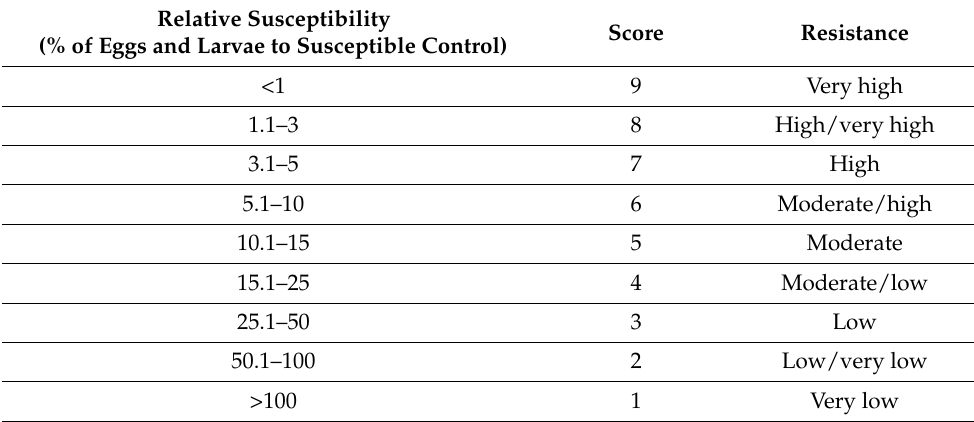
Table 1. EPPO scale for accounting the infestation rate of potato cultivars by G. rostochiensis and G. pallida